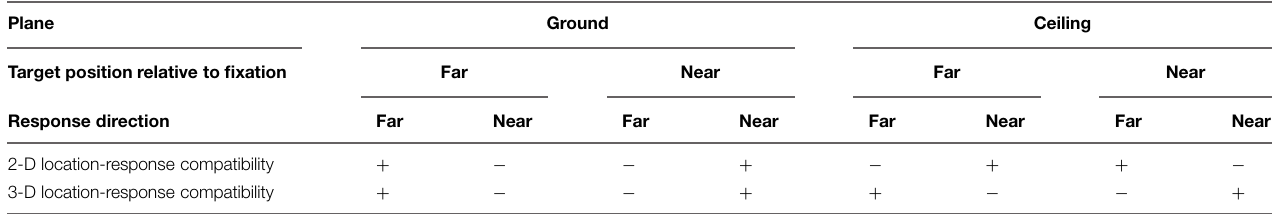
TABLE 1 | The relationships among response-location compatibilities and combinations of the depth of the target and the plane on which the target and the fixation were located. Plane